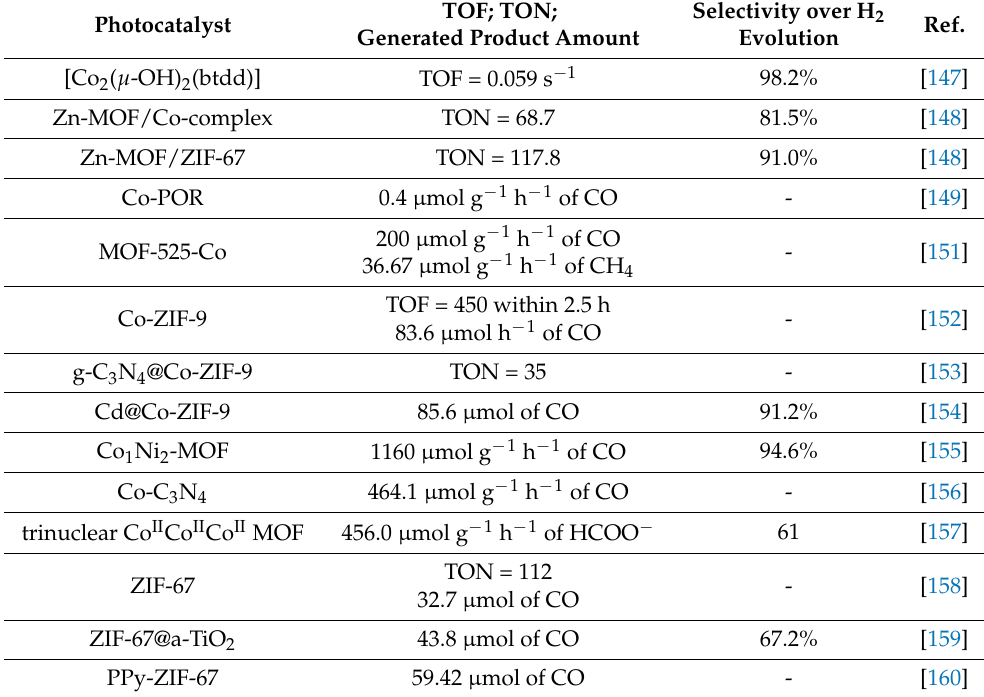
Table 3. Examples of Co-based MOFs used in the photocatalytic CO 2 -to-CO